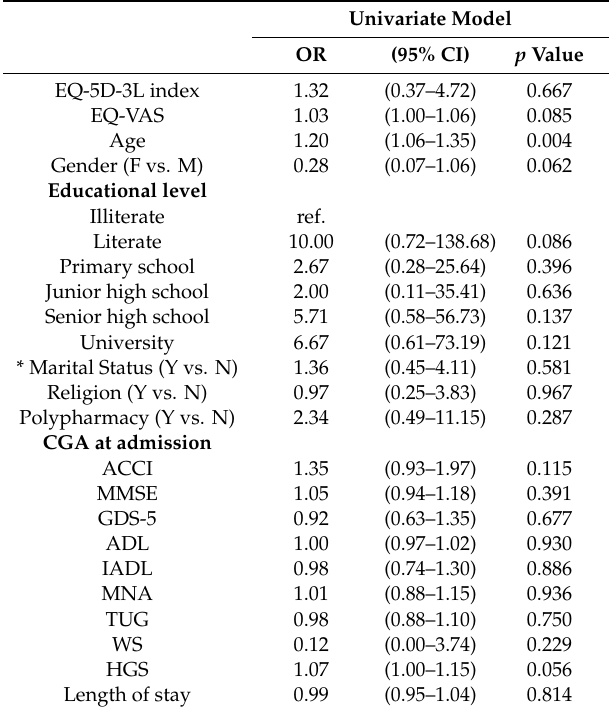
Table 6. Readmission with EQ-5D-3L index, EQ-VAS, and comprehensive geriatric assessment parameters at